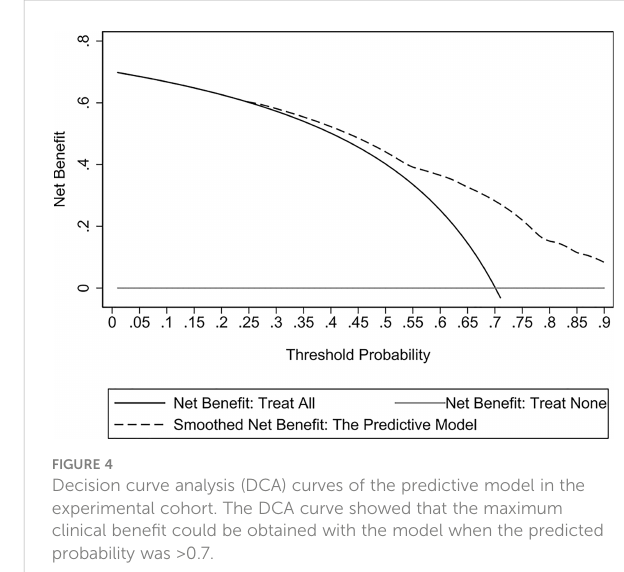
FIGURE 3 Receiver operating characteristic (ROC) curve of the predictive model in the experimental cohort. The predictive model had a good discriminative power with an area under the ROC curve of 0.753 (95% con fi dence interval: 0.685 – 0.820).